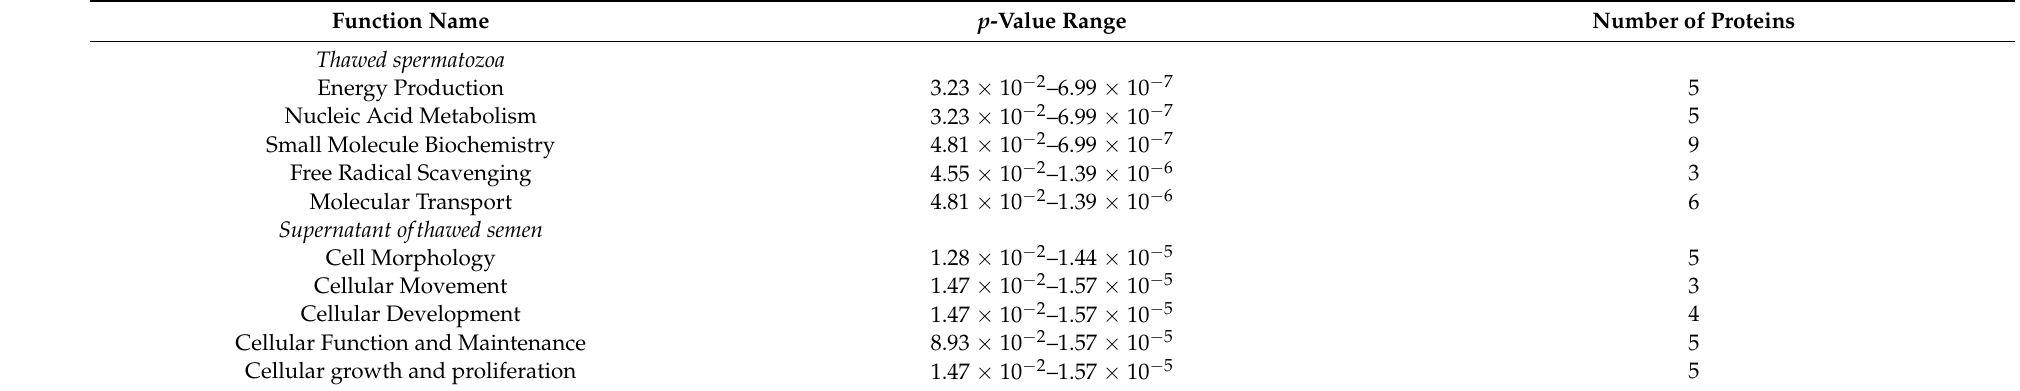
Table 4. Top molecular and cellular functions performed by proteins changing in adult bulls thawed spermatozoa and supernatant of thawed semen in comparison to young bulls thawed spermatozoa and supernatant of thawed